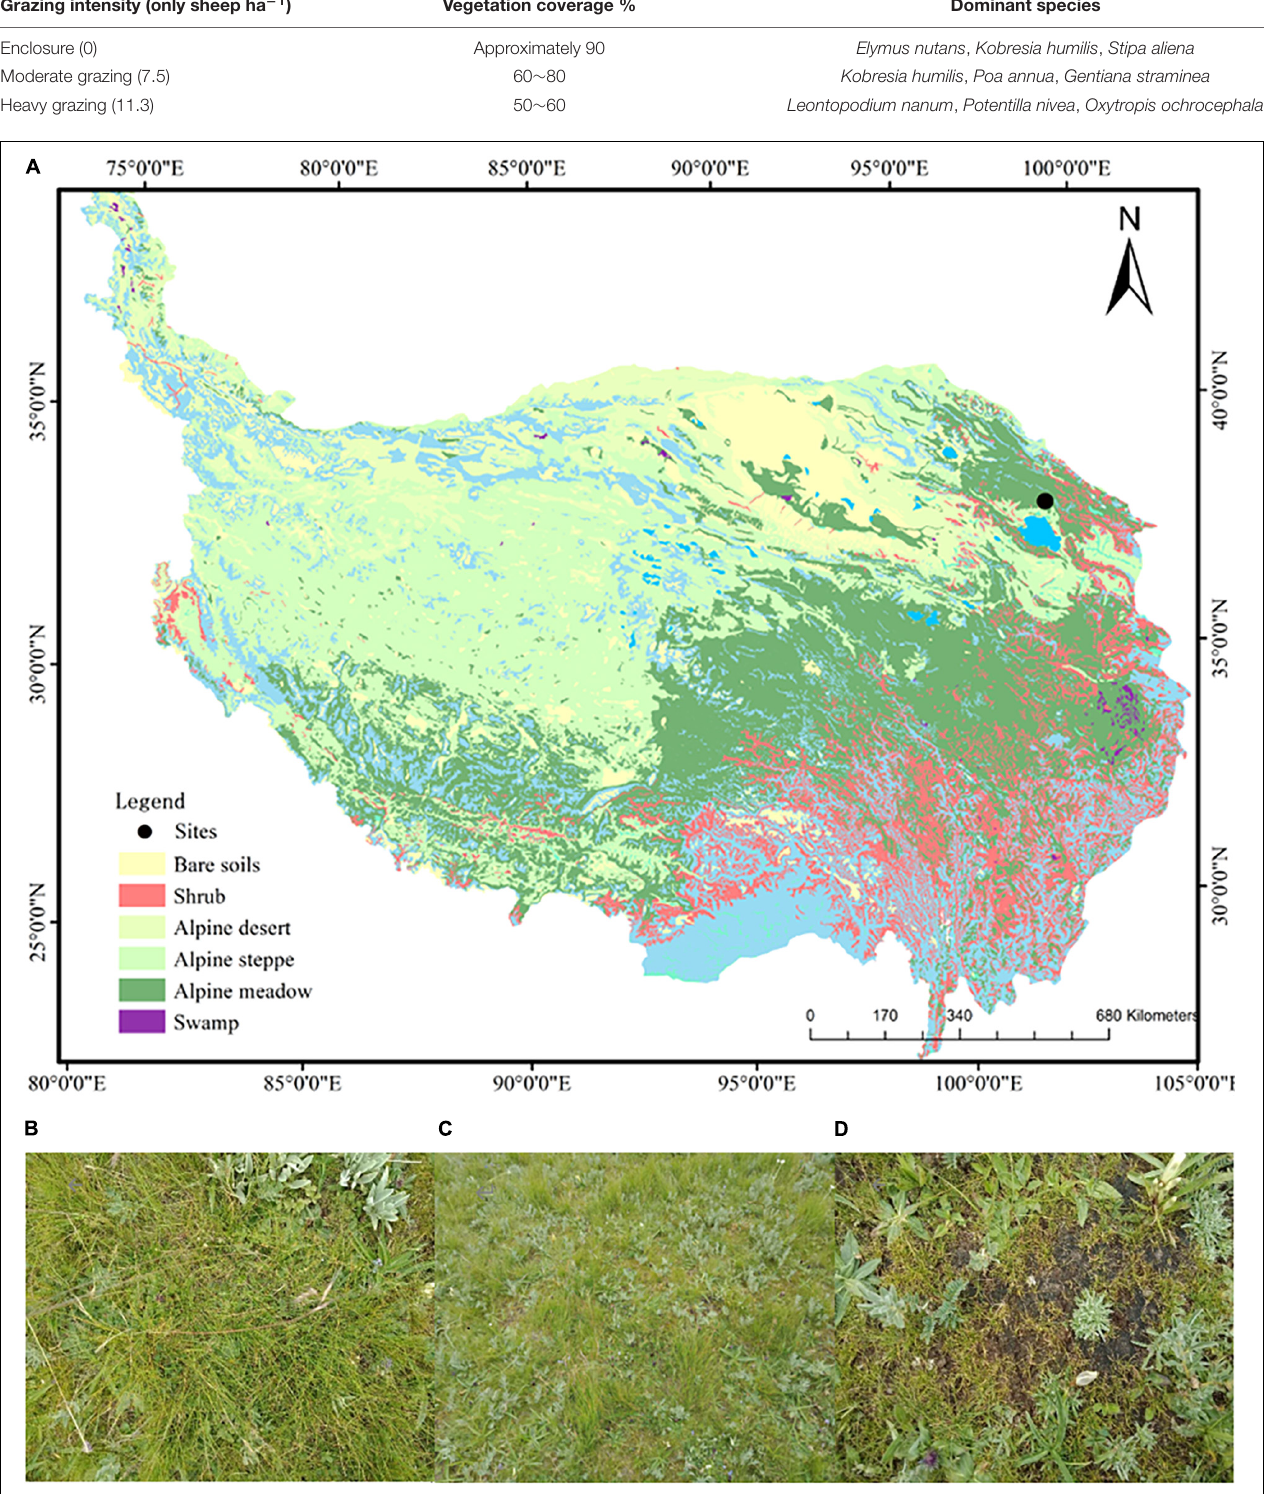
TABLE 1 | Basic conditions of experimental plots of alpine meadows with different grazing intensities. Grazing intensity (only sheep ha − 1 )